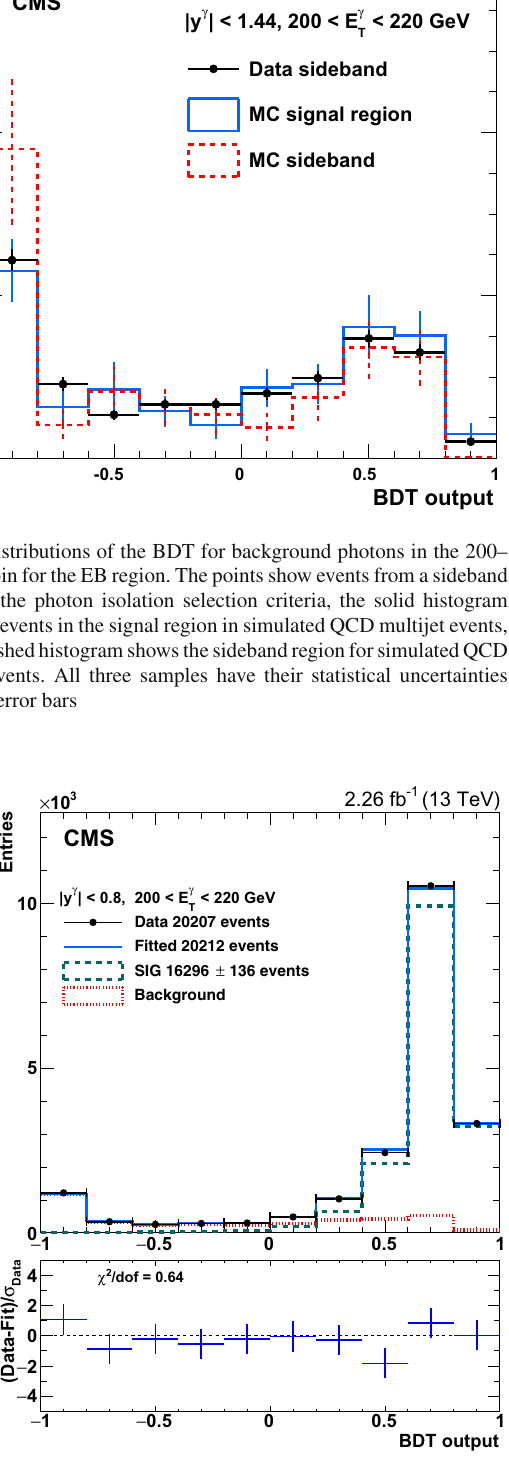
data points, represent the fit results with the signal (dashed) and back- ground (dotted) components displayed. The bottom panels show the ratio of the data to the fitted results and the χ 2